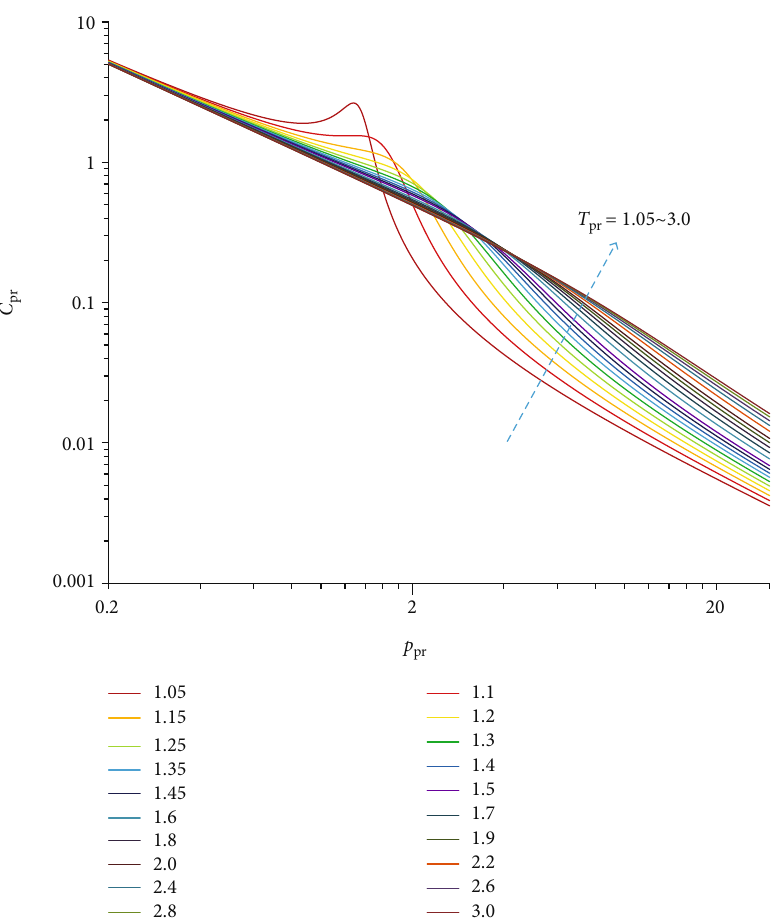
) of natural gases obtained by the Hall-Yarborough correlations at pseudoreduced pressures of pr